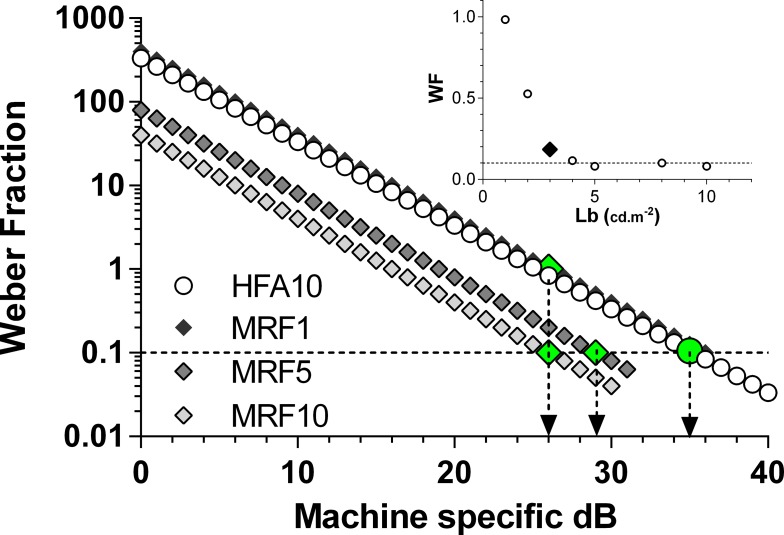
The relationship between equipment specific decibel and the Weber Fraction, on a semi-log plot. Each curve (line on this scale) has been calculated at 1-dB steps (symbols) as detailed in the text. The circles show the relationship for the HFA with the large filled circle (and down arrow) locating a threshold of 35 dB: note this gives a Weber Fraction of 0.1 as indicated by the dashed horizontal. The relationships for the tablet (MRF) at several background luminances (1, 5, 10 cd.m−2) are represented by diamonds with average normal thresholds indicated as large (filled) symbols and down arrows. The 5 and 10 cd.m−2 backgrounds yield a Weber fraction that is similar to 35 dB of the HFA (0.1). The 1 cd.m−2 background results in reduced sensitivity. The inset plots average Weber fraction (y axis) returned from MRF thresholds measured in pilot trials as a function of adapting luminance (x axis). Backgrounds less than 3 cd.m−2 (large filled diamond) produce elevated Weber fractions (reduced retinal sensitivity).